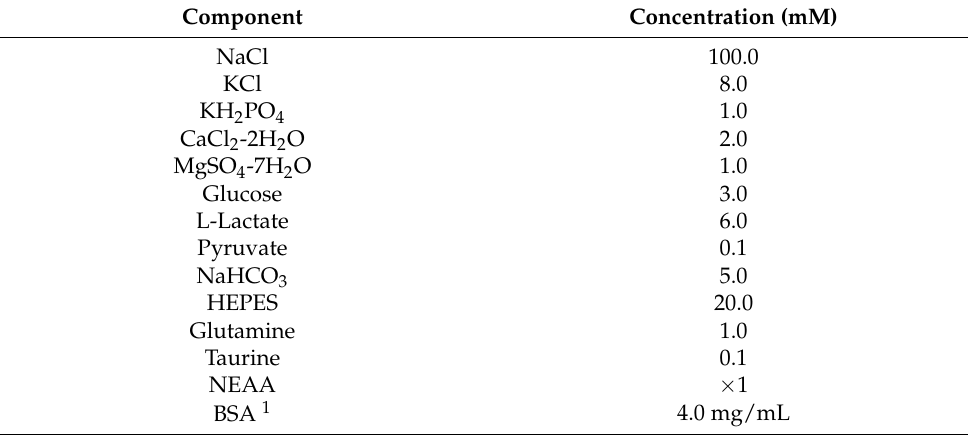
Table 1. Composition of HEPES-buffered feline-optimized culture medium.